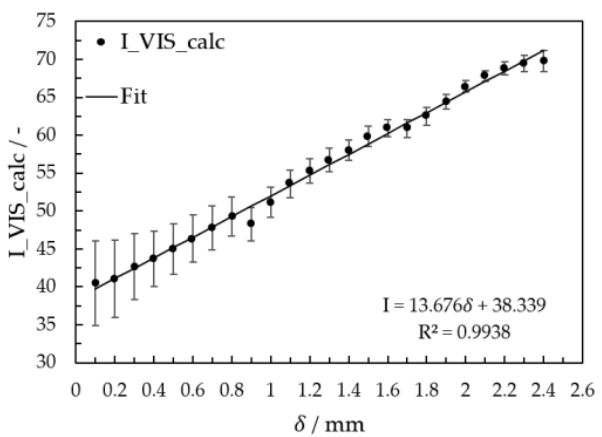
the film thickness. The schematic workflow for VIS image processing is shown in Figure